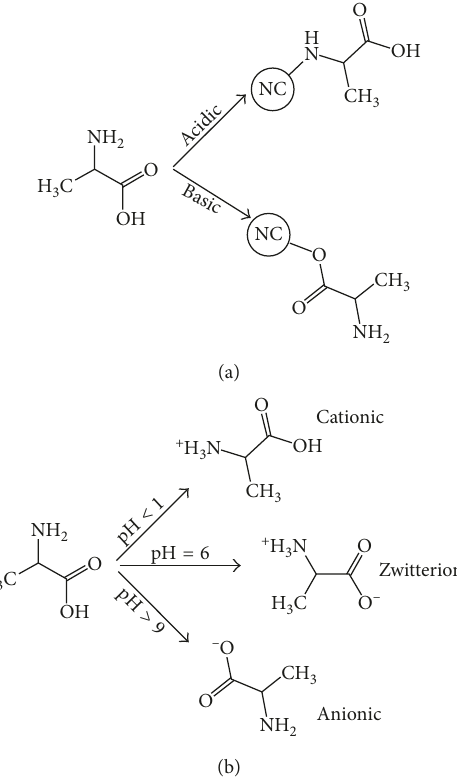
Scheme 1: Representation of the (a) binding motifs of L -alanine on the surface of copper sulphide nanoparticles and (b) effect of pH on L -alanine in an aqueous